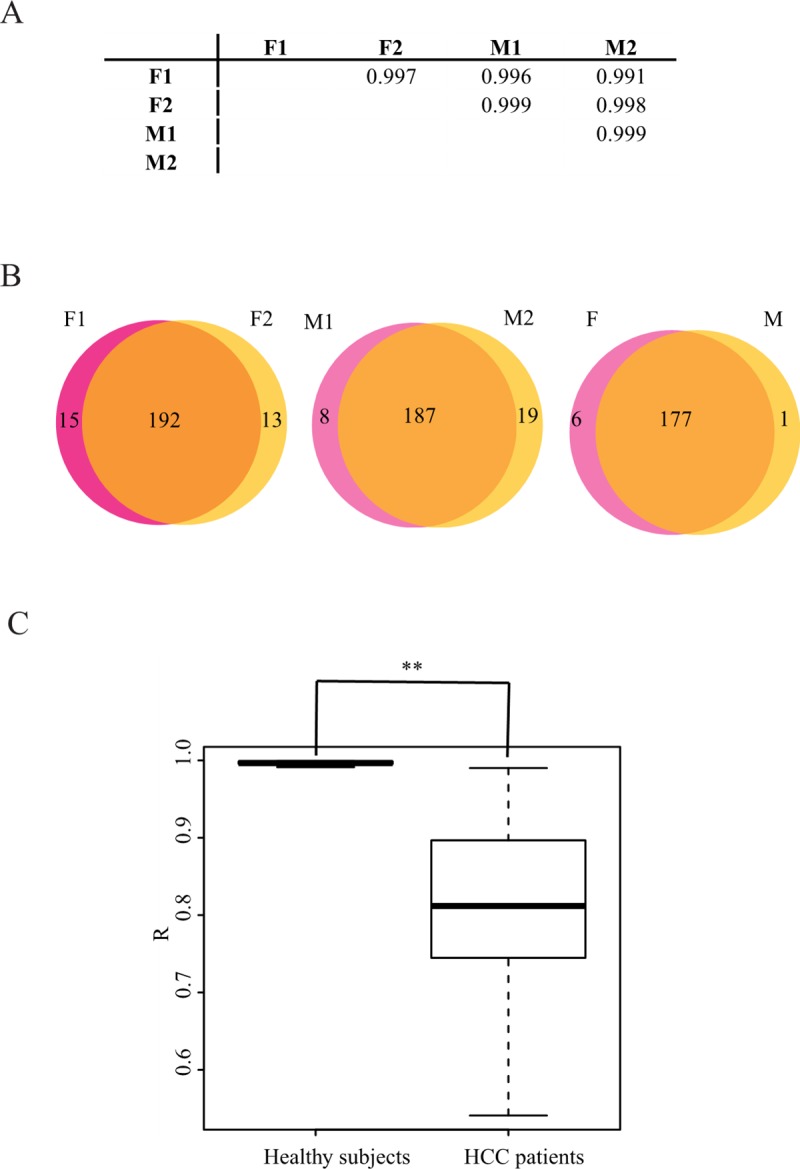
The plasma miRNA profiles are much more variable for HCC patients than those for heathy subjects.A. The correlation coefficients for the pairwise comparison of healthy subjects are close to 1.0 between individuals. F indicates female, and M indicates male. B. The plasma miRNAs have minor gender bias among healthy subjects. miRNAs with an RPM more than 10 were used to analyse the types of miRNAs in the plasma. The types of differential miRNAs between genders are comparable to those within gender. C. Comparison of the Pearson’s correlation coefficient (R) comparison between healthy subjects and HCC patients. The differentiation between these two populations is significant. The P value is less than 0.001.